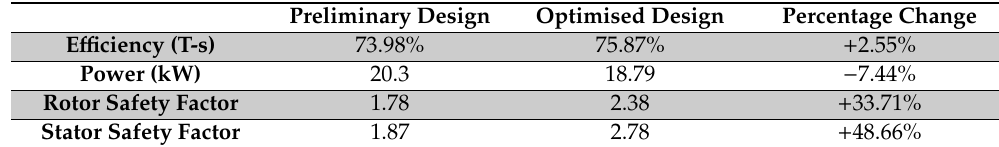
Table 4. Design optimisation final